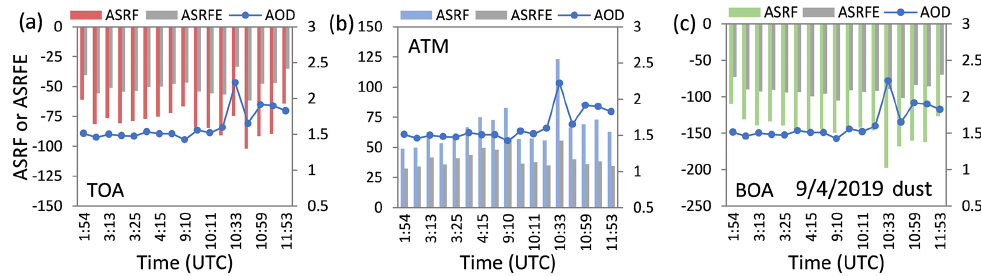
Figure 9. As Fig. 6 but for the two-layer dust case on 9 April 2019.